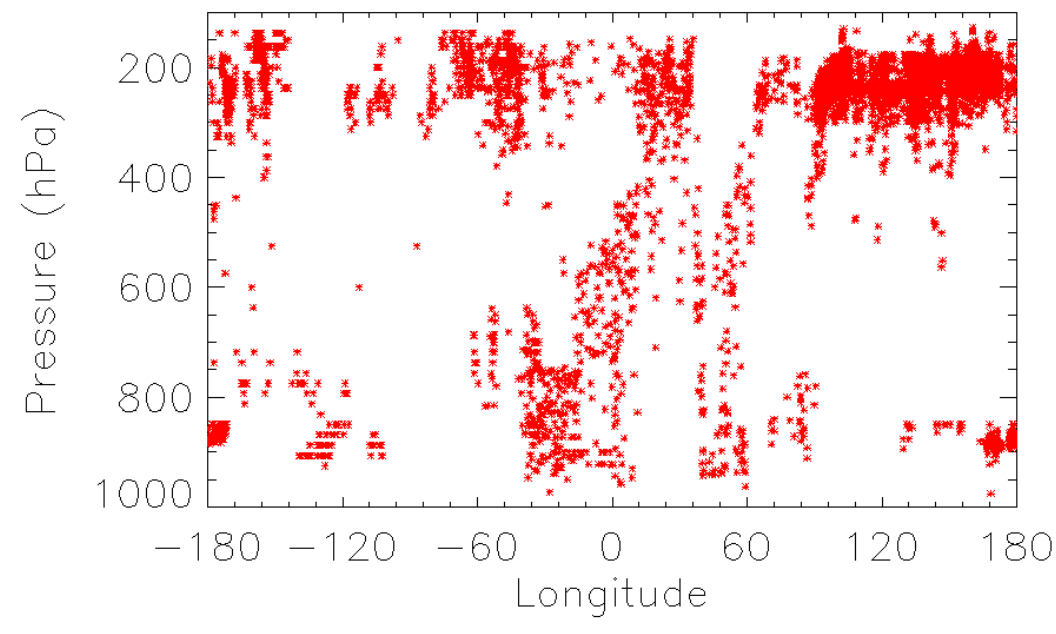
Figure 1. A vertical cross-section of the atmospheric motion vectors for a six-hour period centered on 00 UTC on 10 December 2014 between 5°S and 5°N.